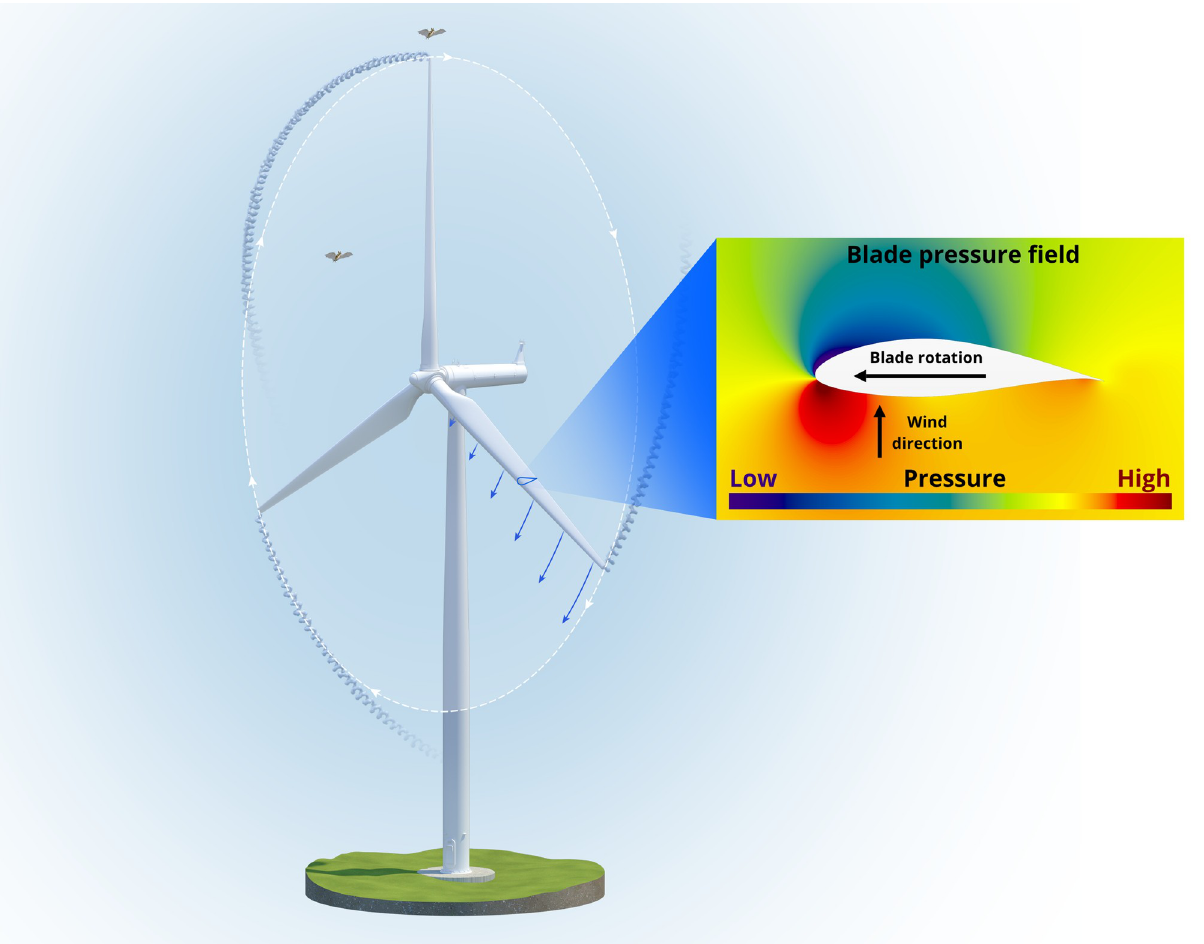
Fig 1. Pressure changes caused by an operating wind turbine. A low-pressure region forms over the blade suction surface (downwind side) and a high-pressure region forms over the blade pressure surface (upwind side of the blade) as a result of local flow accelerations. A region of low pressure is also created by the vortex that forms as air flows around the tip from the blade pressure side to the suction side. The tip-vortex propagates downstream in the direction of the wind as shown.